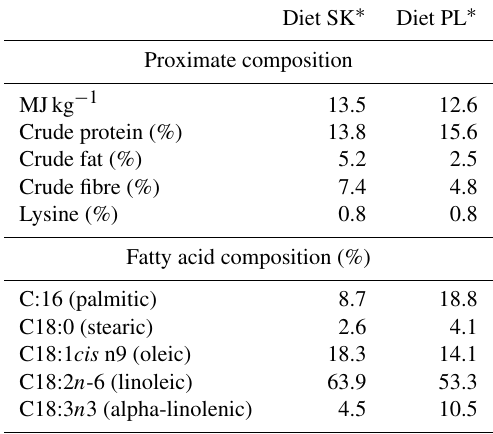
Table 2. Composition of complete feed mixture in Poland. Ingredients % Barley 60 Wheat 20 Post-extraction soybean 12